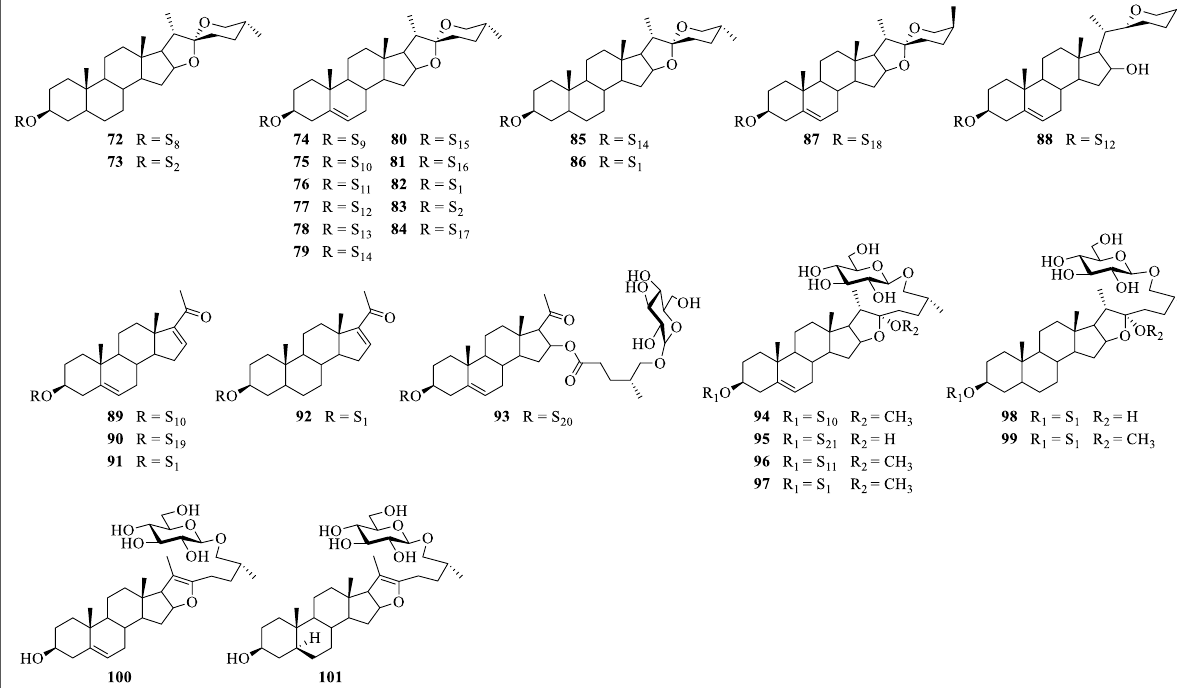
Fig. 10 Chemical structures of steroidal saponins from S. lyratum